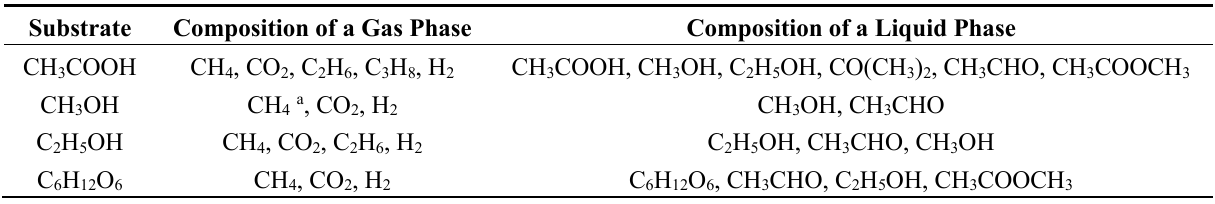
Table 1. Products identified in the gas and liquid phases after 27 h of irradiation over Fe/TiO 2 .